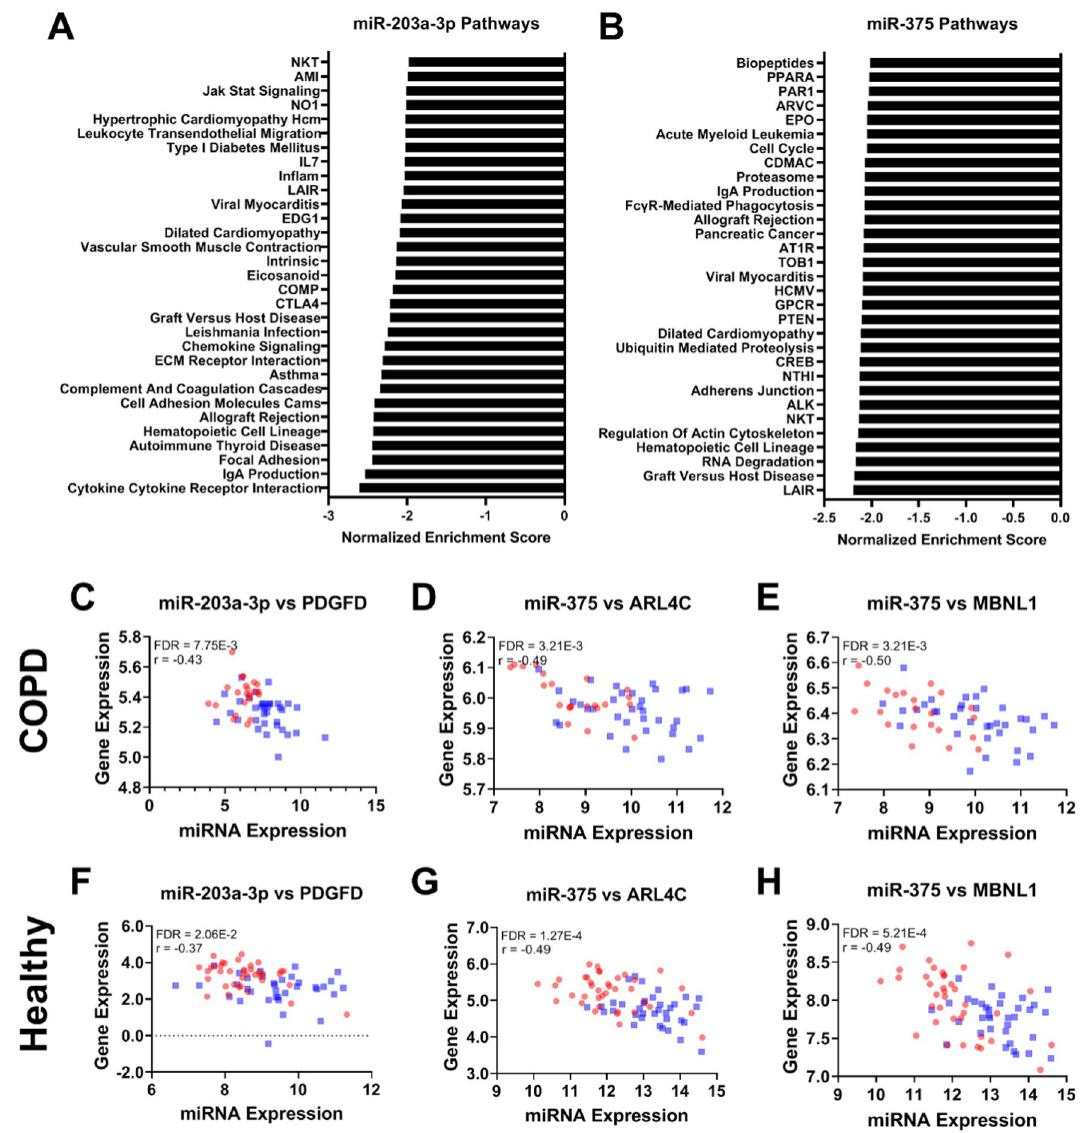
Figure 3. Significant pathway negatively enrichment by miRNA-203a-3p and miR-375 and correlation of aforementioned miRNAs with genes in both COPD patients as well as respiratory healthy controls, excluding correlations that were considered not biologically relevant due to a low r-value. ( A ) Enriched pathways affected by miR-203a-3p in COPD patients. ( B ) The enriched pathways affected by miR-375 in COPD patients. Scatter plots ( C – E ) show the correlation between miRNA expression and gene expression levels in COPD patients for all significant negatively correlated predicted targets; miR-203a-3p and PDGFD , miR-3758, and ARL4C , and miR-375 expression and MBNL1 , respectively. Smoking participants are shown in blue, ex-, and non-smokers are shown in red. Scatter plots ( F – H ) show the correlation between miRNA expression and gene expression levels in respiratory healthy controls between miR-203a-3p and PDGFD , miR-375, and ARL4C , and mir-375 and MBNL1 ,